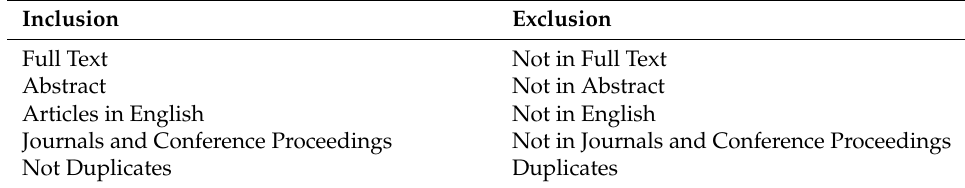
Table 3. Quantitative filters.